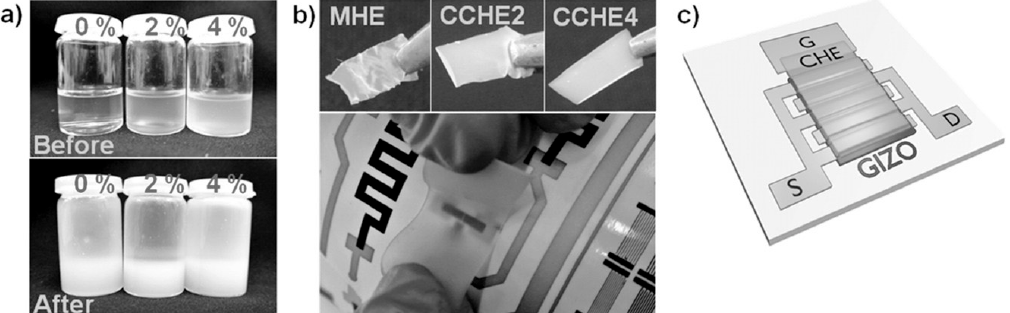
Figure 13. ( a ) Solutions containing various weight ratios of carboxymethyl cellulose (CMC) (0, 2 and 4 wt.%) before and after neutralization with acetic acid. ( b ) Resulting flexible and transparent free- standing cellulose-based hydrogel electrolytes (CHEs) obtained from the respective solutions (MHE, CCHE2, CCHE4). ( c ) Schematic illustration of a CHE-gated IGZO EGT. Reproduced from [70] with permission. Copyright © 2017 Wiley and Sons.